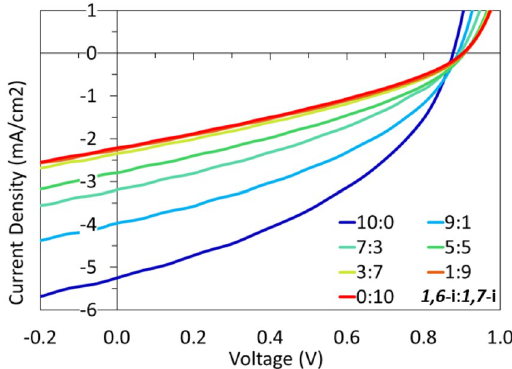
Figure 10. J –V curves of devices prepared with different ratios of 1,6-i and 1,7-i